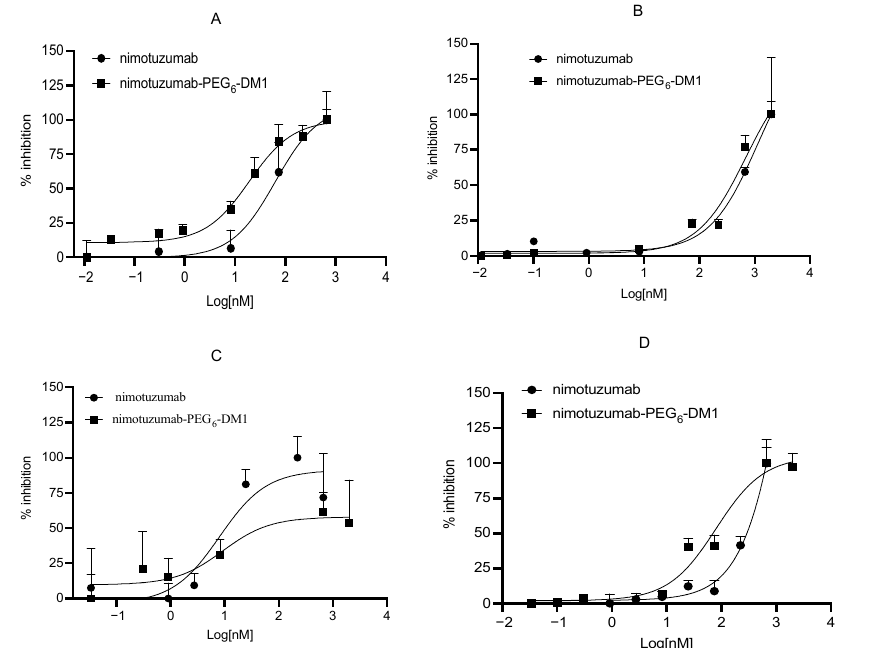
Figure 3. In vitro cytotoxicity of nimotuzumab and nimotuzumab-PEG 6 -DM1 against ( A ) SNU-C2B, ( B ) SW620, ( C ) HT-29, and ( D ) DLD-1 cell lines. The IC 50 values were calculated by plotting the increase in red fluorescent intensity against concentration using Prism 9. All experiments were carried out in triplicates.